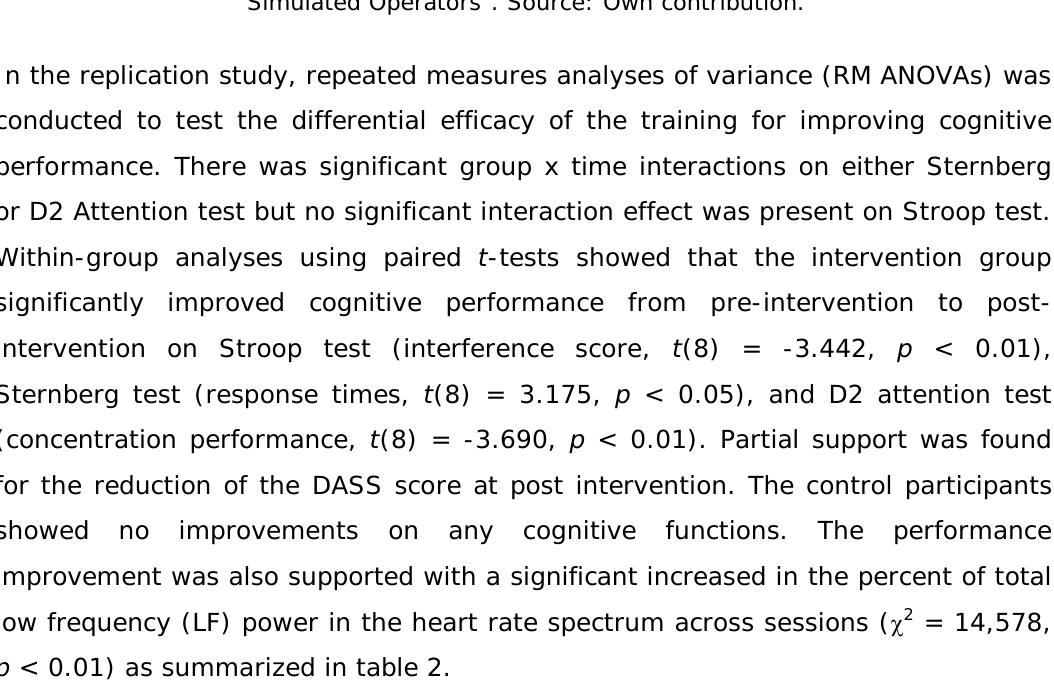
Table 1. “Pairwise comparison of LF Oscillation Change between Subsequent Sessions in Simulated Operators”. Source: Own